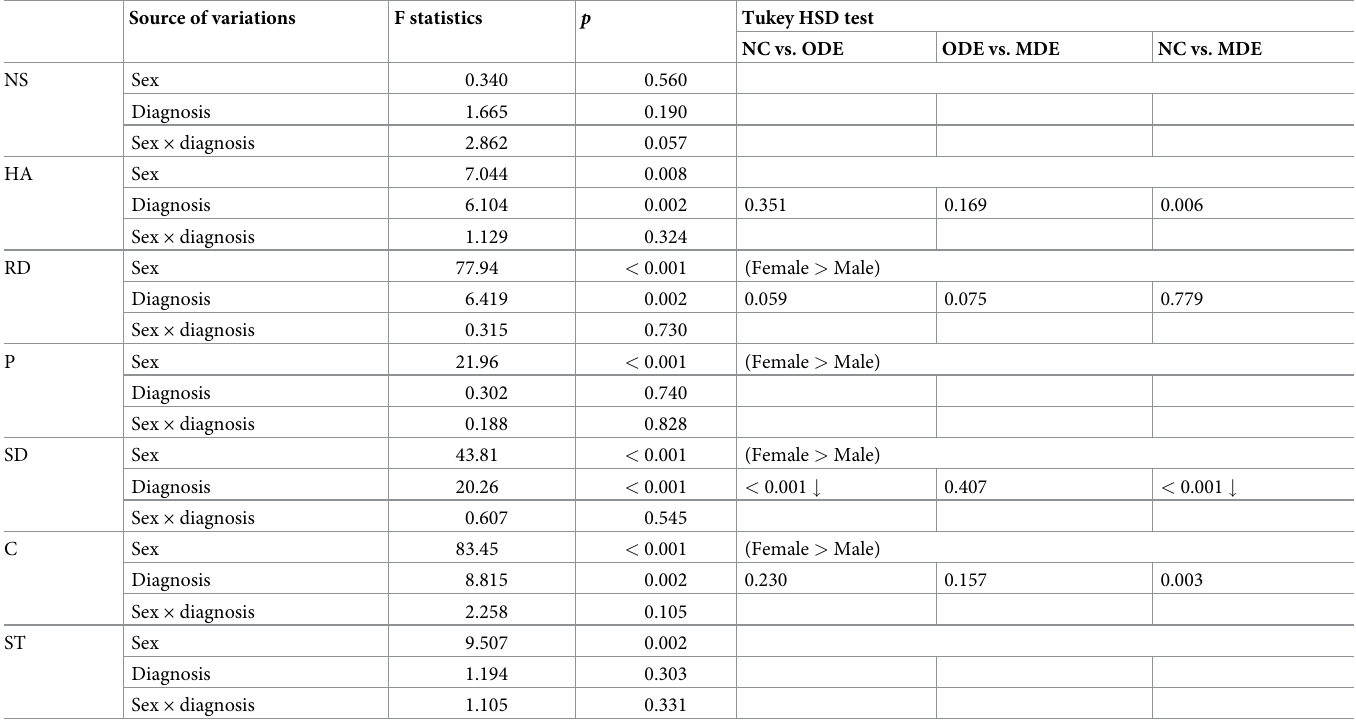
Table 3. Comparison of TCI scores using a two-way ANOVA among NC, ODE, and MDE. Source of variations